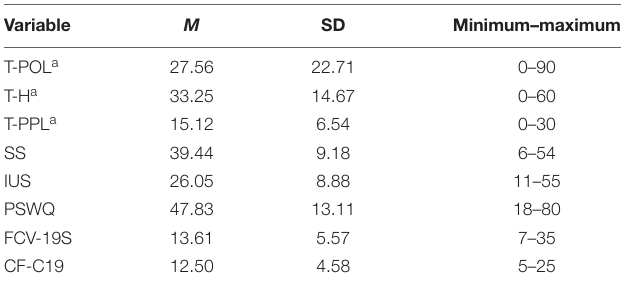
TABLE 1 | Descriptive statistics for the variables used in the